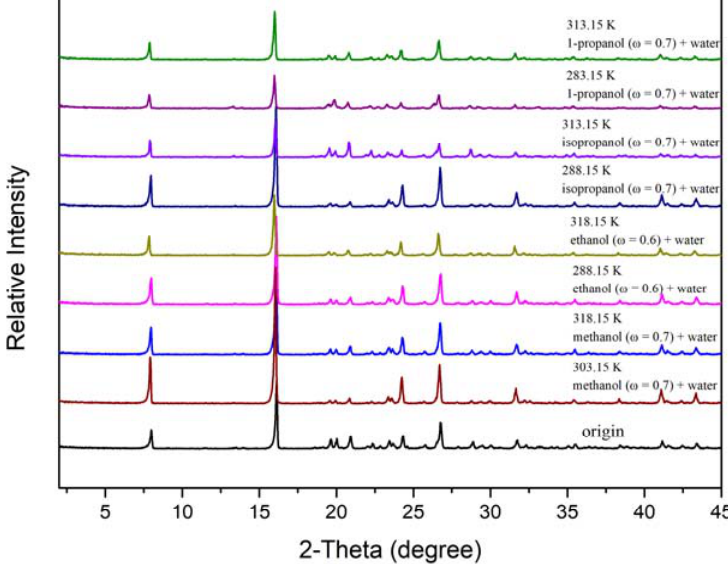
Figure 2. PXRD patterns of florfenicol.